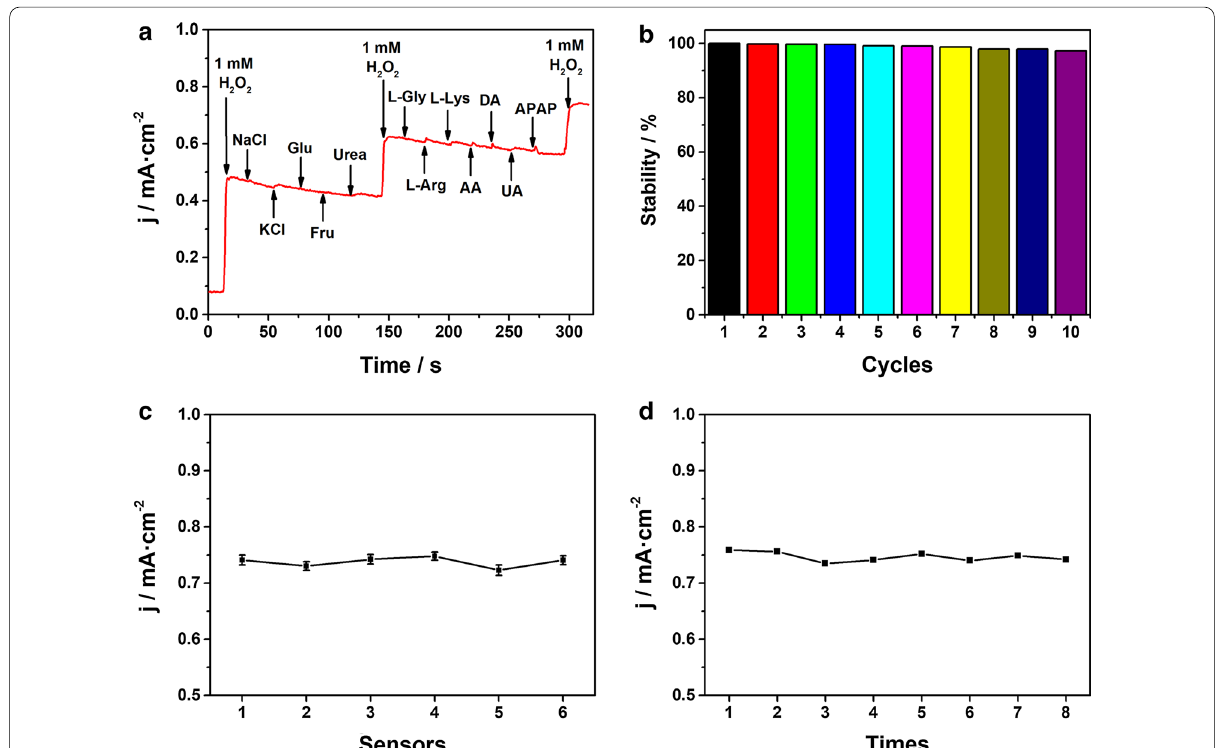
Fig. 4 a Amperometric responses of Co 2 P/ITO electrode with the addition of 1 mM H 2 O 2 and other interfering species (10 mM NaCl, KCl, Glu, Fru, urea, L-Gly, L-Arg, L-Lys, AA; 1 mM DA, UA; 0.5 mM APAP) in 0.1 M PBS. b The cathodic peak currents of ten successive scanning CV curves in 50 μM H 2 O 2 . c Reproducibility of six Co 2 P/ITO electrodes for detecting 1.0 mM H 2 O 2 . d Repeatability of Co 2 P/ITO electrode for detecting 1.0 mM H 2 O 2 eight